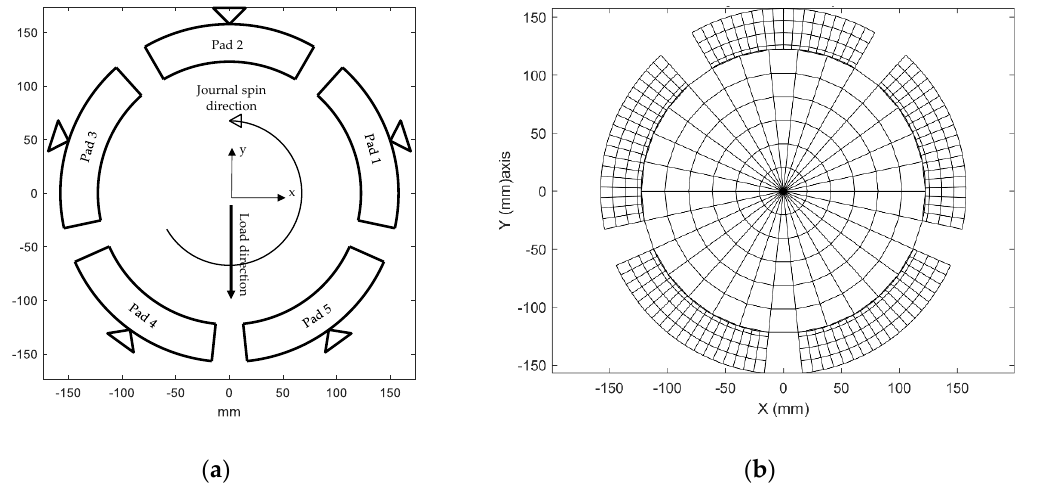
Figure 7. Tilting pad journal bearing model: ( a ) geometry check plot and load direction; ( b ) bearing finite element model.